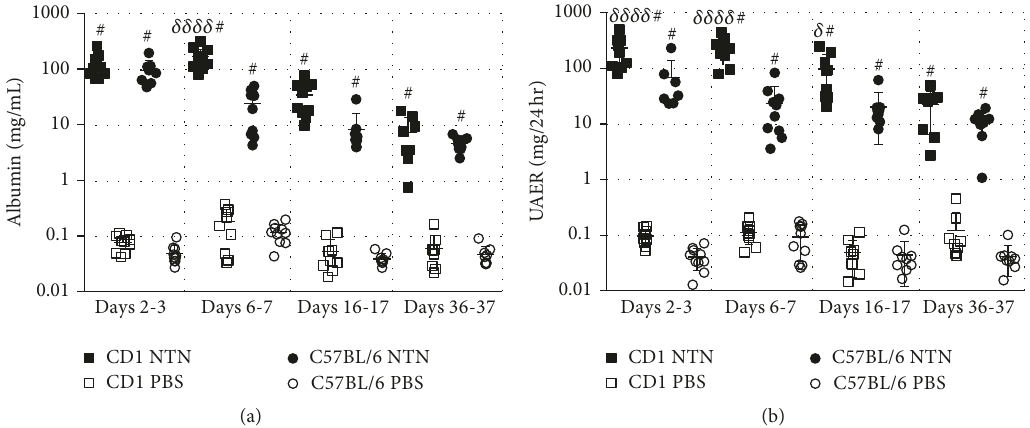
Figure 3: NTS induces significant and chronic increase in UAER and urine albumin concentration . (a) Scatter plot showing the 24 h urinary albumin excretion rate (UAER) on days 2-3, 6-7, 16-17, and 36-37. (b) Scatter plot showing urinary albumin concentration on days 2-3, 6-7, 16-17, and 36-37. Data are shown as mean ± SD. # 𝑃 < 0.0001 NTN groups versus PBS groups and 𝛿 𝑃 < 0.05 , 𝛿𝛿𝛿𝛿 𝑃 < 0.0001 CD1 NTN versus B6 NTN groups by two-way ANOVA ( 𝑛 = 10